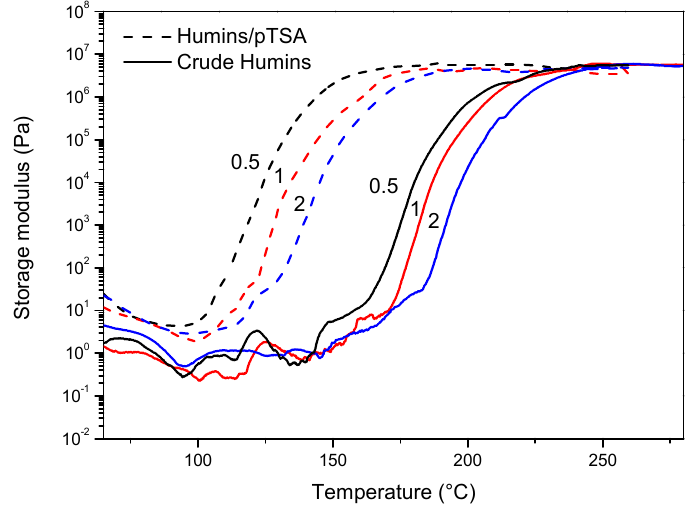
Figure 5. Storage modulus ( G ’) variation with the temperature at different heating rates (0.5, 1 and 2 °C·min − 1 ), for crude humins (solid lines) and humins/pTSA (dash lines).